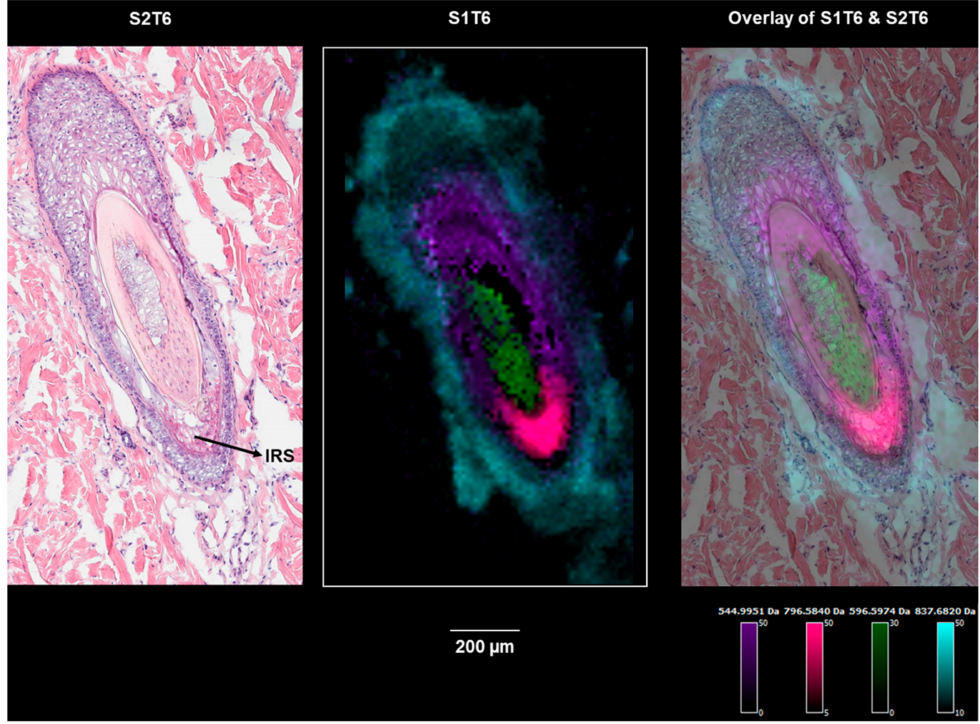
Figure 6. Ion images of m / z 544.9959 (a cortex marker), m / z 837.6818 (an outer root sheath marker), m / z 596.5974 (a medulla marker), and m / z 796.5840 (an inner root sheath marker) on section S1T6 showing hair follicle-3 (the bulge